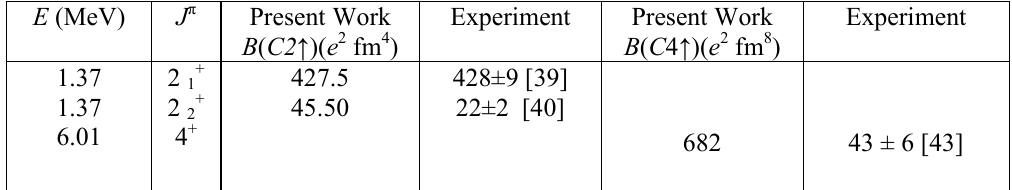
Table 2: Comparison of experimental transition probabilities with predictions of Present Work for positive-parity states in 24